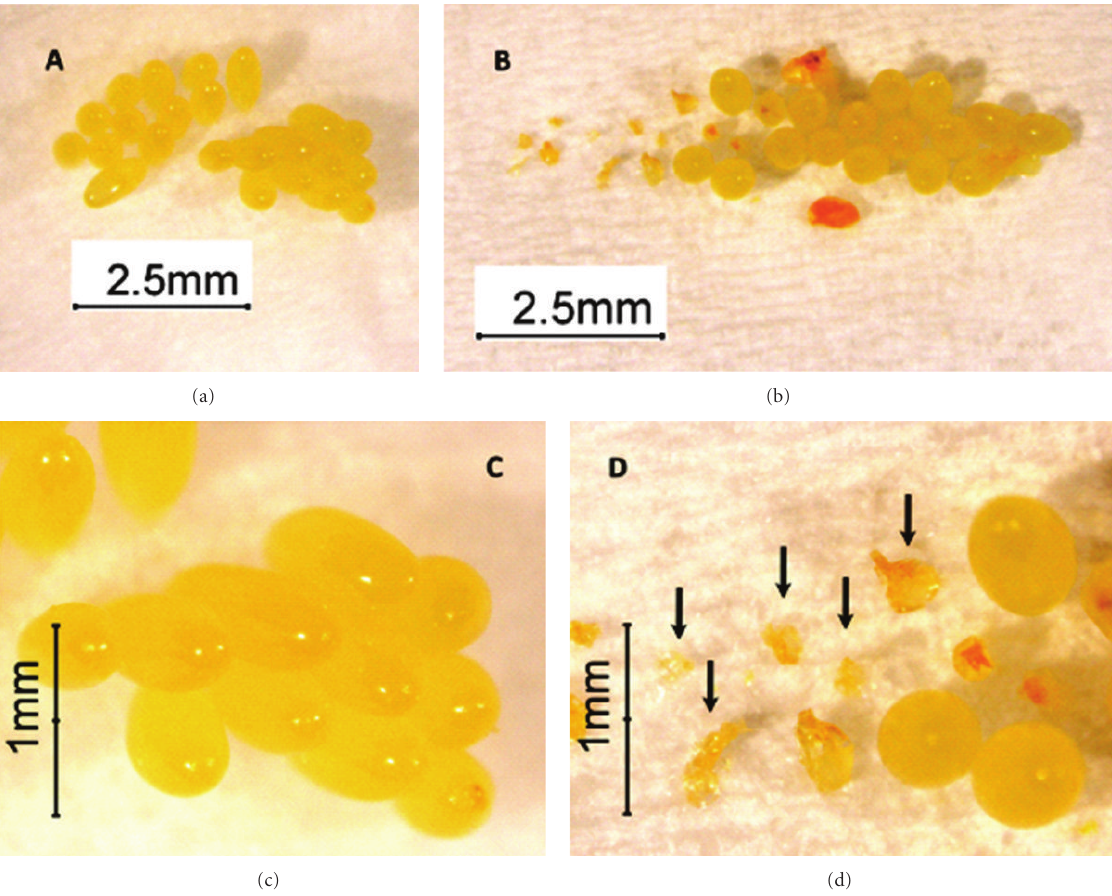
Figure 2: Intact (noncannibalized) eggs of C. maculata in a mass (a, c) and cannibalized eggs in a mass (b, d). Arrows indicate remnants of cannibalized eggs on substrate